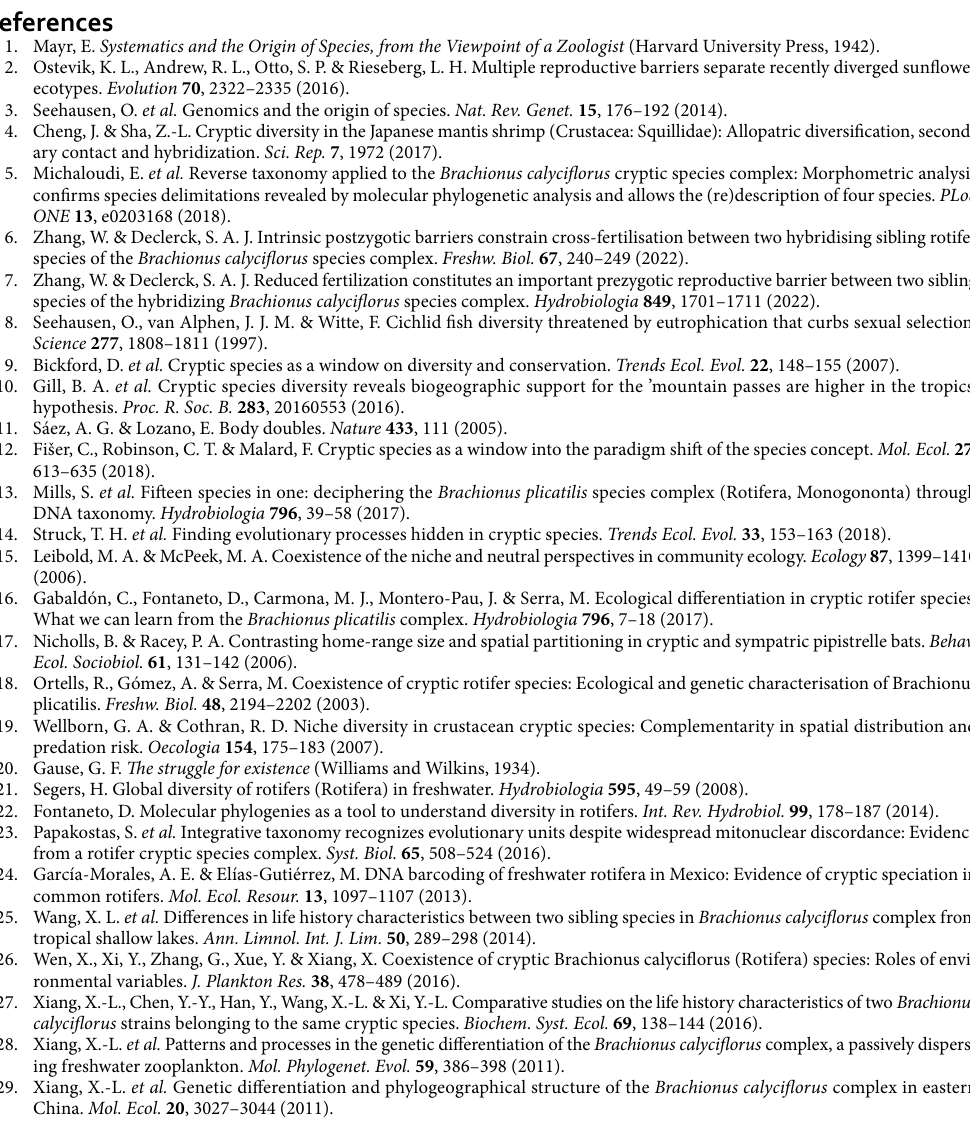
FigTree version 1.4.4. and adapted in Inkscape version